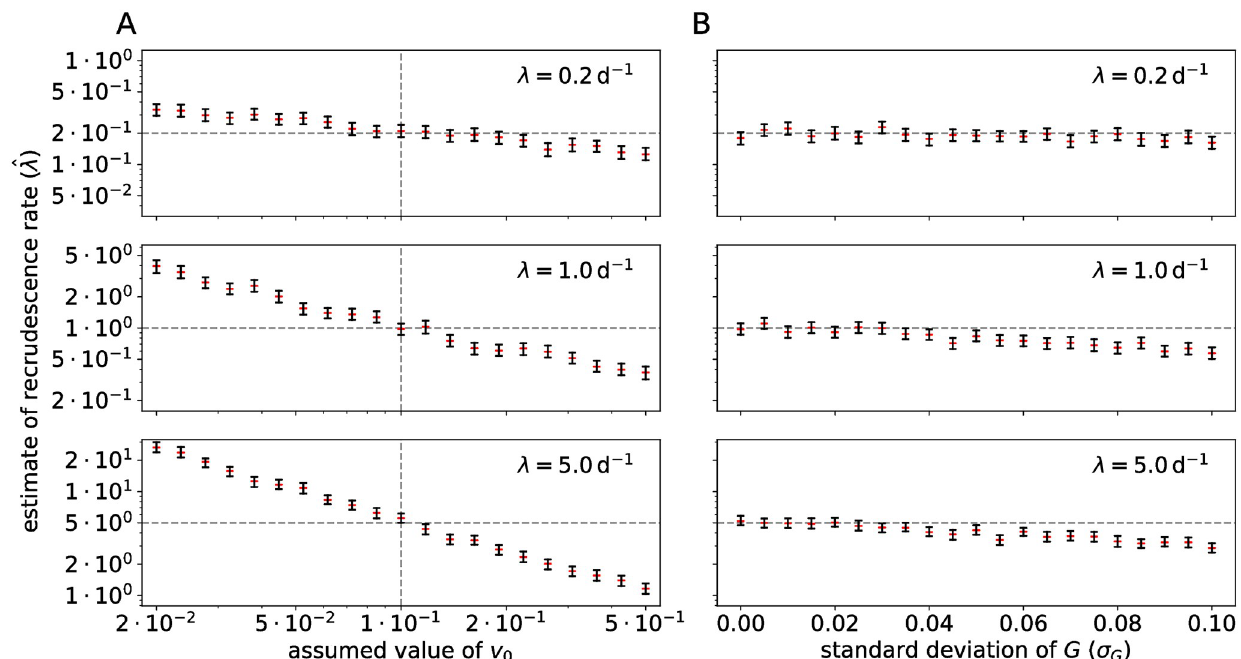
Fig 5. Sensitivity of the multiple-reactivation model to misspecification. (A) A misspecified initial viral load v 0 can lead to a biased estimate of the recrudescence rate λ . Rebound data sets ( n = 200) were simulated by sampling from the viral load process (Eq 1) using different values of the recrudescence rate λ (horizontal dashed lines), and different assumed values of v 0 (horizontal axis). The ground truth value of v 0 equals 0.1 copies mL − 1 (vertical dashed lines). Shown are the 95% CrIs of the estimate ^ l of λ (black bars) and the posterior medians (red). (B) Intra-host variation in the exponential growth rate of the VL can lead to a biased estimate of the recrudescence rate λ . Data sets of rebound time series were now simulated from a viral load process with within- host variability of the growth rate G i (Eq S12 in S1 Text, S5 Fig), using different values of the recrudescence rate and the standard deviation of the viral growth rate ( σ , horizontal axis), ranging from 0% to 20% of the most likely growth rate g = G